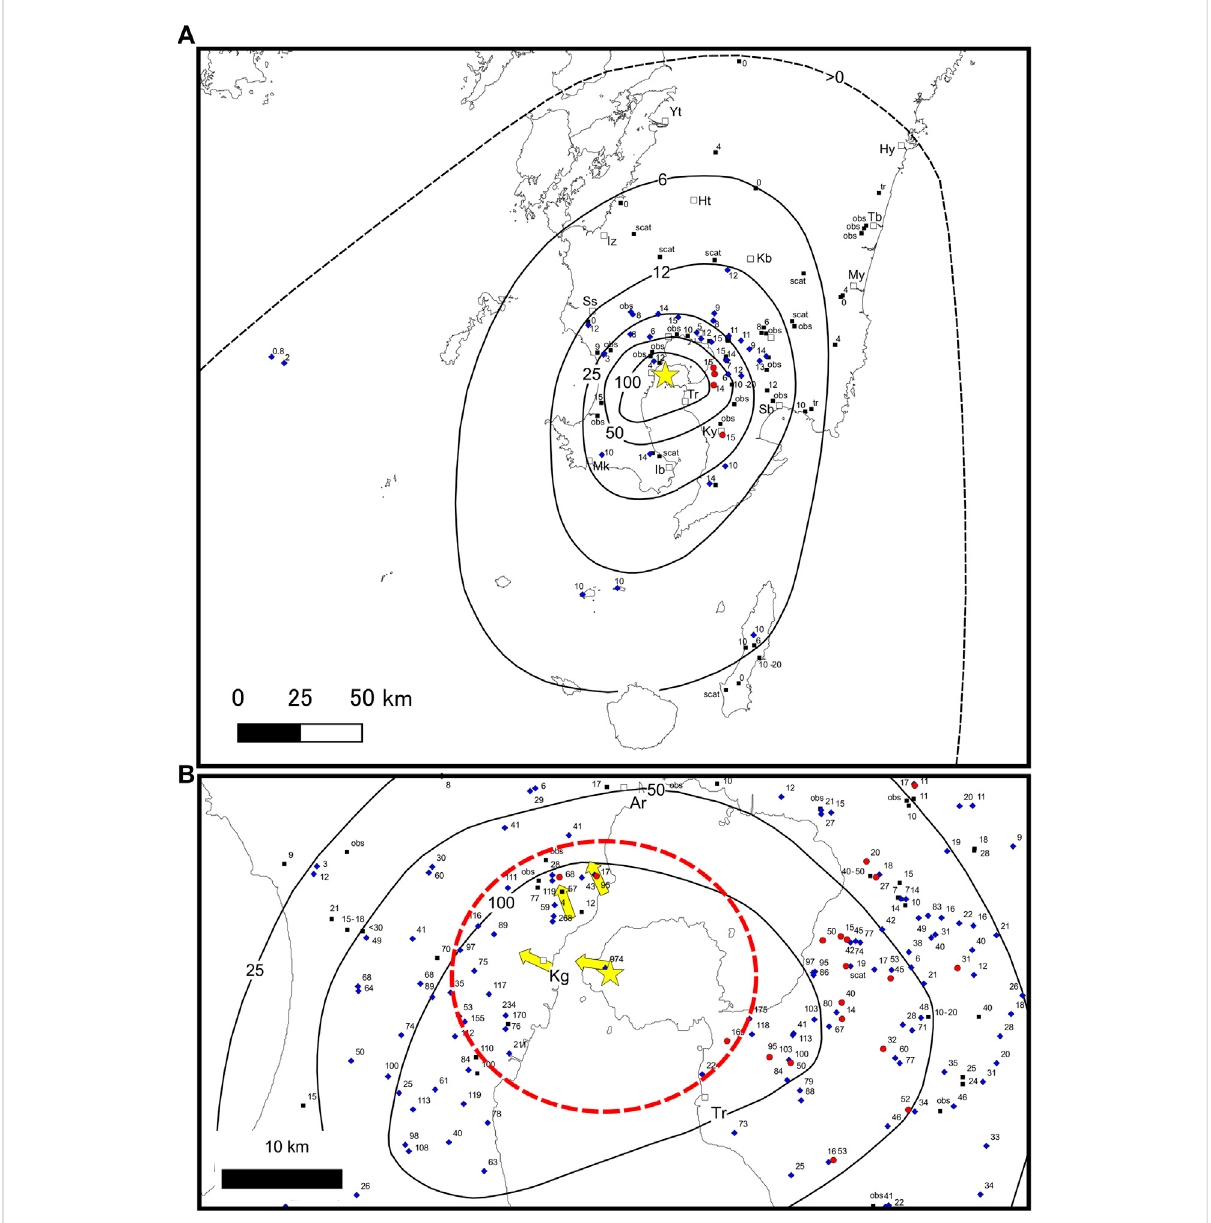
FIGURE 6 (A) Distribution oftheP14pumicefalldeposit.Legend isthesameinFigure3A.Theisopachcontoursof > 12 cmareafterKobayashietal.(2013). The points on the map show only those with & 15 cm in thickness. The yellow arrows represent the PDC fl ow directions estimated from the carbonized wood contained in the P14 PDC deposits (Ishikawa et al., 1972; Kobayashi and Tameike, 1999). The yellow star in the western part of Sakurajima volcano represents the assumed vent locality of the P14 eruption (Kobayashi and Tameike, 1999). Solid white squares indicate the location of major cities, and the abbreviations are the followings: Ht, Hitoyoshi city; Hy, Hyuga city; Ib, Ibusuki city; Iz, Izumi city; Kb, Kobayashi city; Ky, Kanoya city; Mk, Makurazakicity; My, Miyazaki city; Sb, Shibushi city;Ss, Satsumasendai city; Tb, Takanabe Town; Tr, Tarumizu city; Yt, Yatsushiro city. (B) ThedistributionoftheP14tephradepositaroundSakurajimavolcano.IntervalsoftheisopachcontoursarethesameinFigure6A.Thedotted red line shows the assumed distributions of the P14 PDC deposit. Solid white squares indicate the location of major cities, and the abbreviations are the followings: Ar, Aira city; Kg, Kagoshima city; Tr, Tarumizu